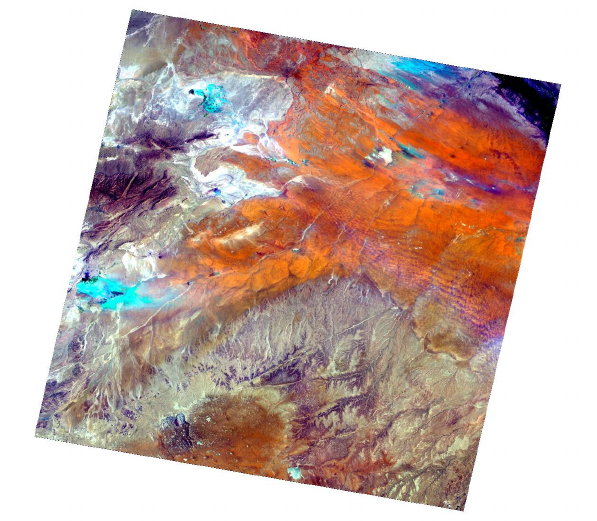
Figure 8. Landsat-7 ETM-image 172/36 (WRS-2), date 26.05.2001, channel 741.